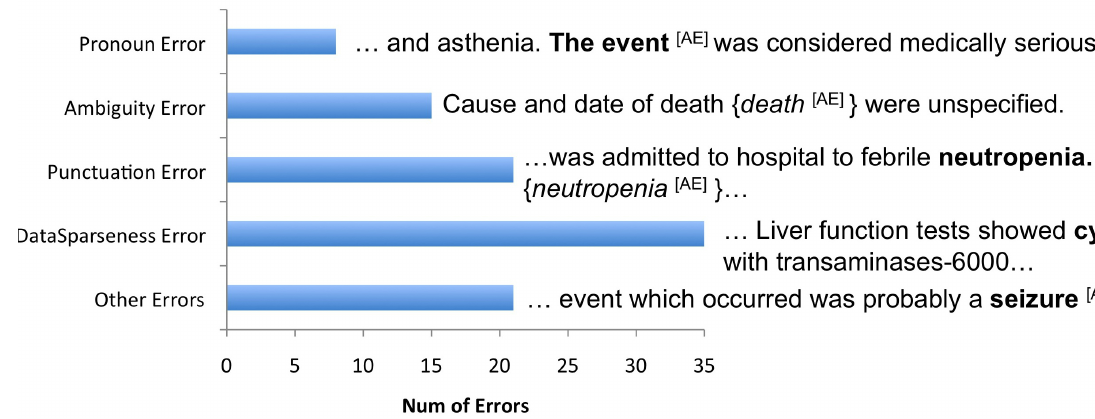
Figure 3. Error categories, their frequency, and an illustrative example of error category on 100 randomly sampled instances. The annotated entities are shown in bold, the annotated named entity type is shown within “[]” and tagger output is {italicized}. AE: adverse